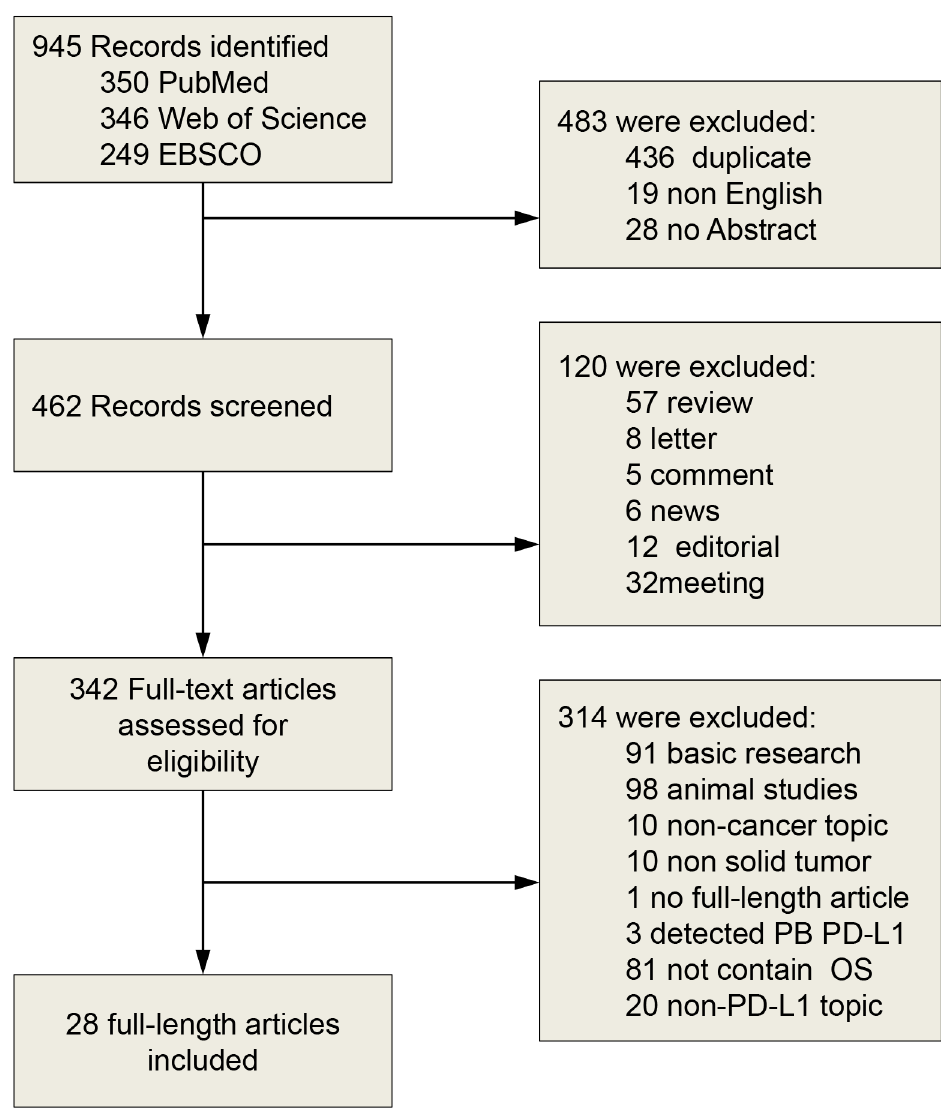
Fig 1. Flow diagram of literature search and study selection. PB, peripheral